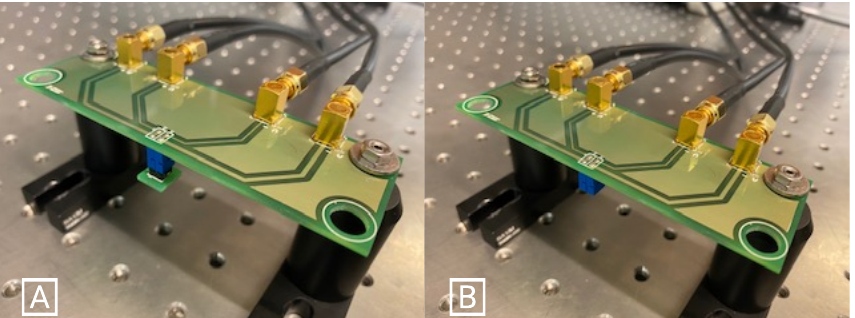
Figure 15. Calibration setup. ( A ): Short-circuit. ( B ): Open-circuit. To compare the experimental measurement of the fabricated coils with the FEM model used as reference, the thirteen LCR measurements were averaged. During the experimental evaluation process, the maximum deviation registered in both PCBs was around 0.68% for the one-layer coils, and 0.48% for the 2-layer coils, which proves